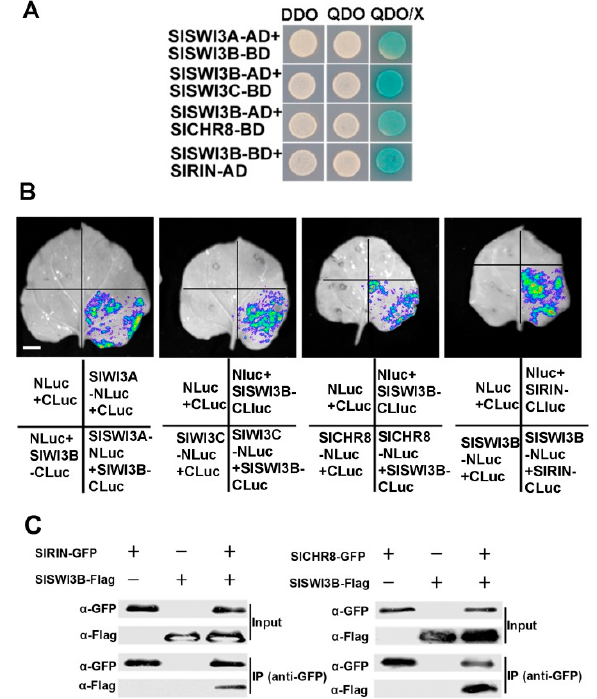
Figure 4. SlSWI3s interacted with SlSWI3A, SlSWI3C SlRIN, and SlCHR8 proteins. ( A ) SlSWI3B interacted with SlSWI3A, SlSWI3C SlRIN and SlCHR8 in yeast-two-hybrid assays. SlSWI3B was either cloned into pGBKT7 or pGADT7 vectors, whereas SlSWI3A , SlSWI3C and SlCHR8 were cloned into pGBKT7 vector, and SlRIN was cloned into pGADT7 vectors, respectively. Di ff erent constructs were cotransformed into the yeast strain AH109. The transformants were grown on the selective minimal medium without Leu and Trp (DDO). The transformants were also plated on QDO or QDO / X to test for possible interaction. QDO, SD / -Leu / -Trp / -His / -Ade. X, x-a-gal. The same results were obtained in three independent experiments, and one representative result was shown. ( B ) SlSWI3B interacted with SlSWI3A, SlSWI3C SlRIN and SlCHR8 by LCI assay. The A. tumefaciens carrying the indicated construct pairs were injected into tobacco leaves, and the luciferase activities were measured 2 d after injection. Similar results were obtained in three independent experiments, and one representative result was shown. Bars = 0.5 cm. ( C ) SlSWI3B interacted with SlRIN and SlCHR8 by Co-IP assay.The SlSWI3B and SlRIN (or SlCHR8 ) were subcloned into the pHB (Flag tag) and pEAQ-GFP (GFP tag) vector, respectively.These constructs were co-transformed into tobacco cells by Agrobacterium mediated infiltration. Transiently expressed SlSWI3B-Flag and SlRIN-GFP (or SlCHR8-GFP) were immunoprecipitated with an anti-GFP antibody, and then detected by western-blotting assay with an anti-Flag